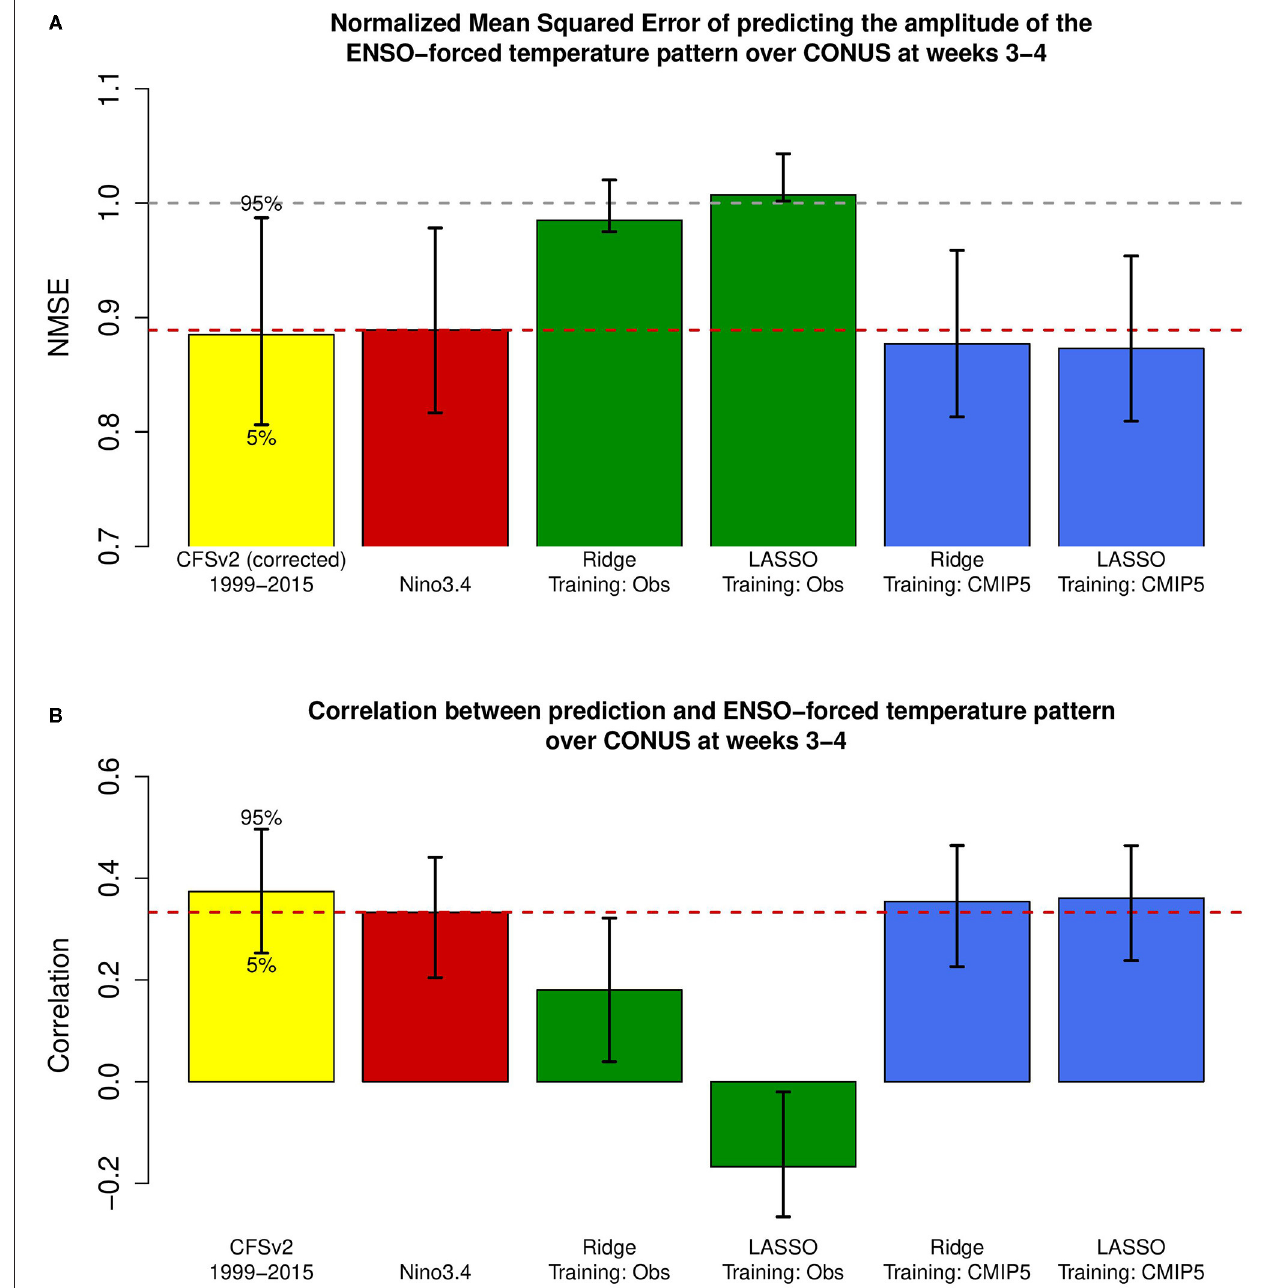
FIGURE 2 | (A) Cross-validated normalized mean squared errors of predictions of the ENSO-forced temperature pattern, and (B) the associated correlation skills for the following models (from left to right): CFSv2 hindcast; ordinary least squares based on the Nino3.4 index; ridge regression trained on observed SST; lasso regression trained on observed SST; ridge regression trained on CMIP5 model simulations; lasso regression trained on CMIP5 model simulations. The validation time period for the CFSv2 hindcast is 1999–2015. The validation time period for the empirical models (right 5 bars) is 1981–2018. The empirical models only use tropical Pacific SST grid points as predictors. Error bars show the 5% and the 95% levels, calculated using a bootstrap method.